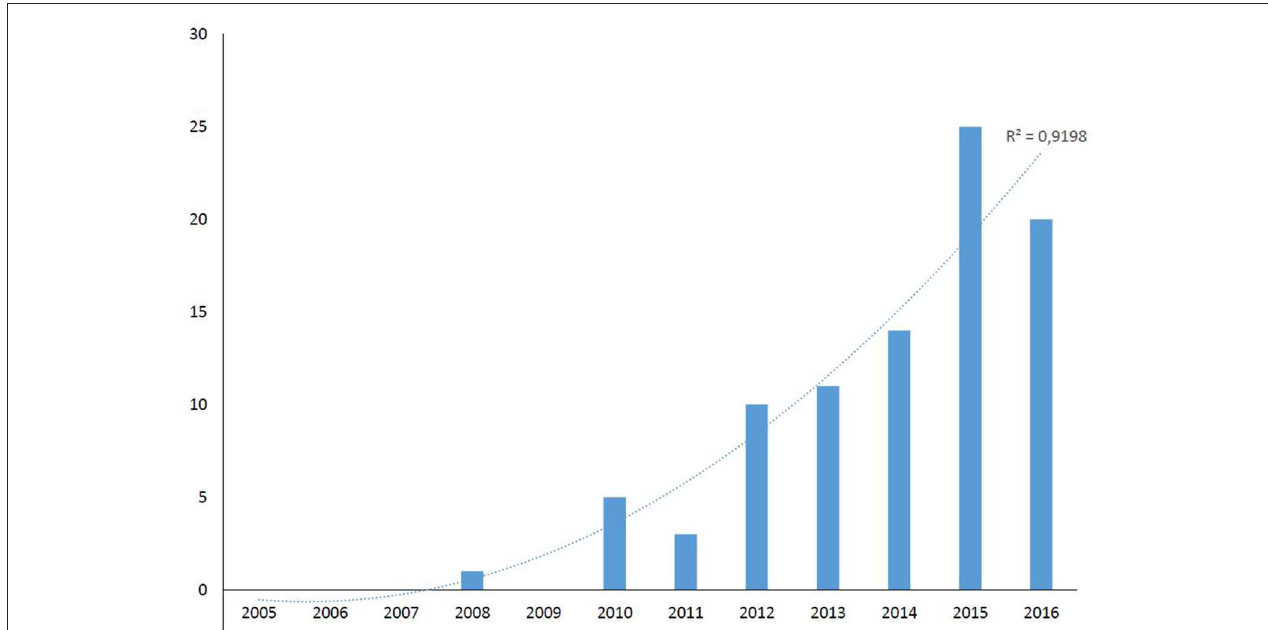
FIGURE 1 | Number of Fusarium keratitis cases in The Netherlands during the period 2005 − 2016.